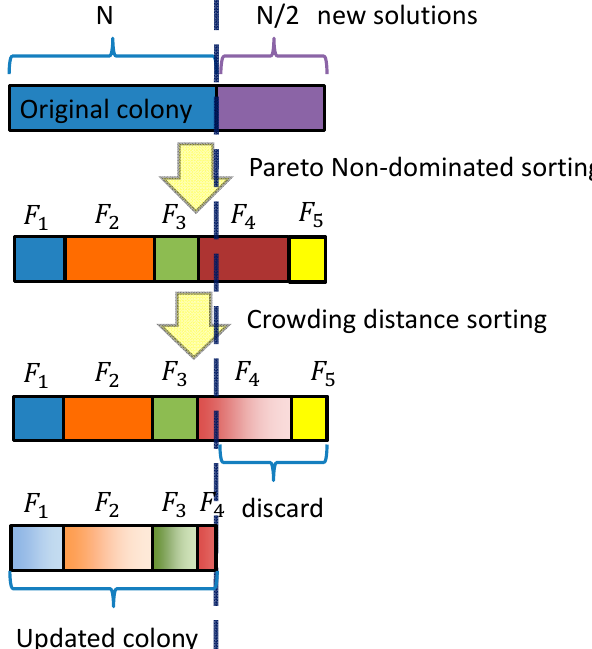
Figure 5. Sorting of the original N solutions and the N /2 new, based on the Pareto non-dominated sorting and crowding distances, where only the best N solutions are reserved in the next iteration.